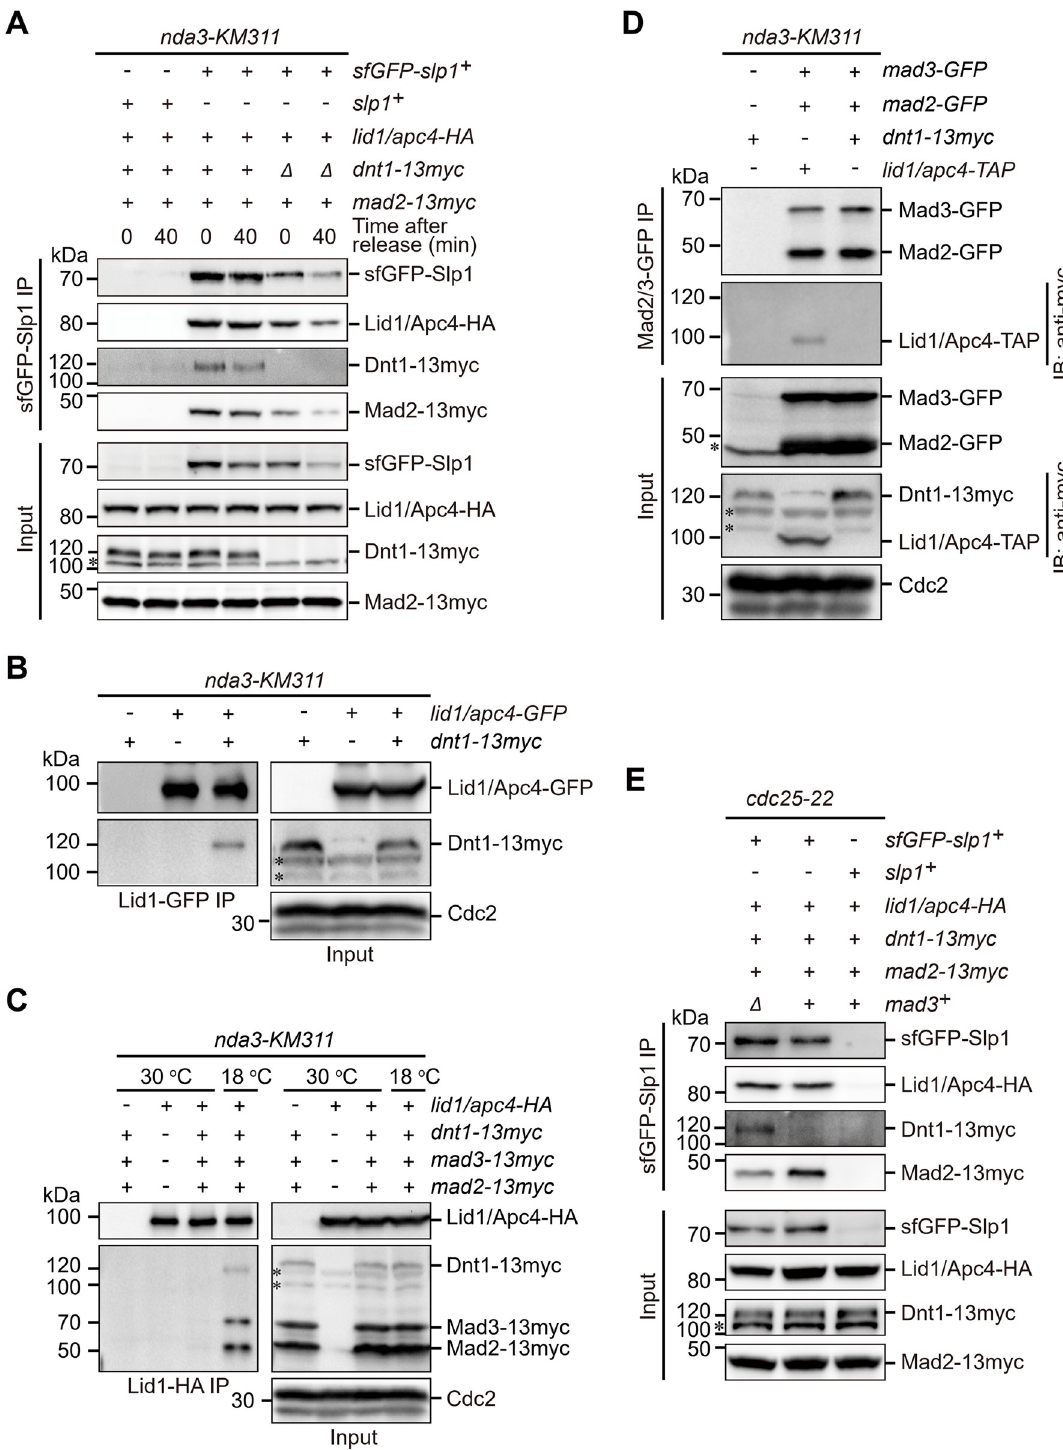
Fig 5. Dnt1 associates with APC/C upon SAC activation and during anaphase initiation. ( A ) Slp1 Cdc20 co-immunoprecipitates Dnt1 in metaphase-arrested and mitosis-exiting cells. nda3-KM311 mad2-13myc strains simultaneously carrying either sfGFP-slp1 or dnt1-13myc or both were arrested in mitosis at 18˚C and then released to 30˚C, samples were collected at 0 and 40 min. Whole-cell extracts (input) were incubated with GFP-Trap beads and immunoprecipitated (IP) fractions were analyzed by immunoblotting. ( B, C ) Dnt1 can be co-immunoprecipitated by Apc4/Lid1 in metaphase-arrested but not asynchronous interphase cells. nda3-KM311